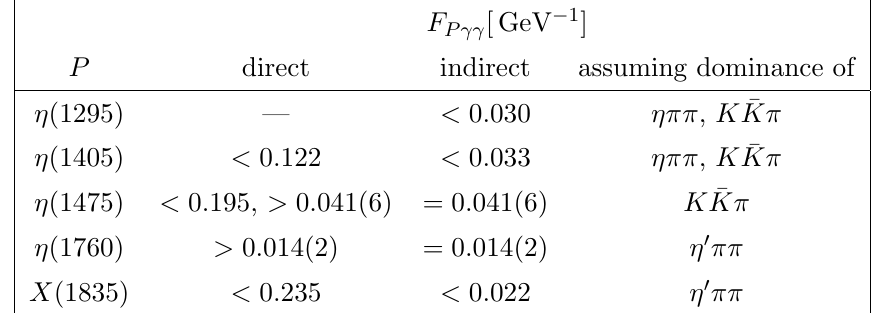
Table 4. Constraints on the two-photon couplings of excited (cid:17) ( 0 ) states, as collected in appendix D. The column labeled \direct" includes constraints that follow directly from branching fractions listed in the PDG, while the column labeled \indirect" lists results obtained when assuming that the channels from the last column are